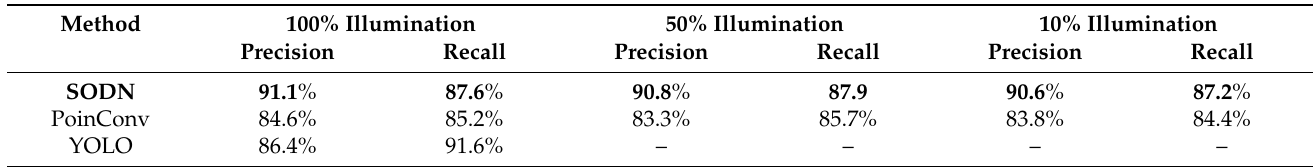
Table 2. Performance in the stacked objects classification